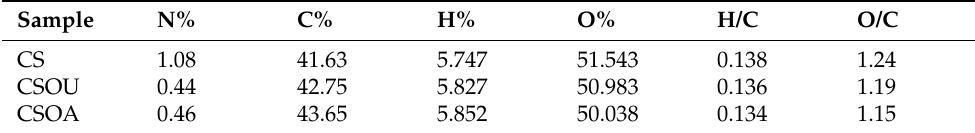
Table 2. Elemental analysis of the untreated and treated samples.